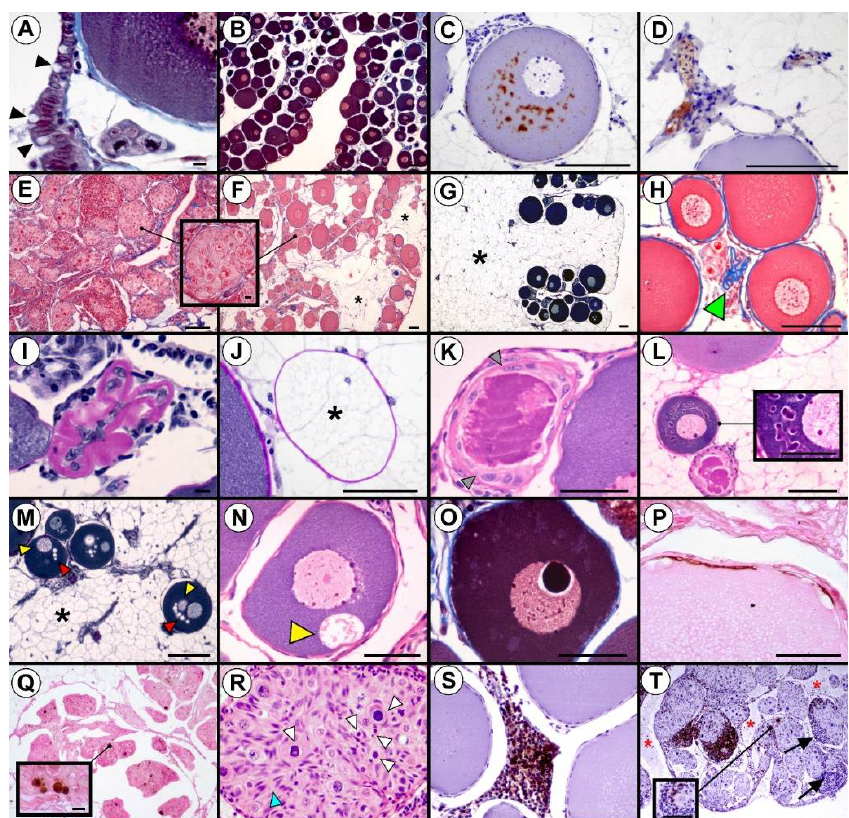
Figure 2. Ovaries of 1600th-day-post-hatching (dph) Russian sturgeon. ( A ) Columnar epithelium in the furrows of the folds. ( B ) Growing ovarian follicles containing perinucleolar oocytes in primary growth stage. ( C ) Deposition of vitellogenin (brown) in ooplasm of small perinucleolar oocyte and ( D ) blood vessel plasma. ( E ) Nests of oogonia and oocytes at the chromatin-nucleolus stage. ( F ) Ovarian nests among sparse ovarian follicles. Magnification between ( E ) and ( F ): Oogonia and oocytes at the chromatin-nucleolus stage inside the ovarian nest. ( G ) White fat tissue in the germinal region of the gonad. ( H ) Final phase of follicular atresia. ( I ) Residual follicular cells and ( J ) adipocytes inside a completely phagocytized follicle. ( K ) Advanced stage of follicular atresia. ( L ) Normal ovarian follicle (at the top), early stage of follicular atresia (in the middle) and advanced stage of follicular atresia (at the bottom). Magnification inside ( L ): Heterogeneous ooplasm of degenerating perinucleolar oocyte. ( M ) Vacuoles and ( N ) autophagosomic bodies within the ooplasm of degenerating perinucleolar oocytes at an early stage of follicular atresia. ( O ) Large vesicles in the nuclei of degenerating perinucleolar oocytes at early stage of follicular atresia. ( P ) Follicular cell apoptosis (brown nuclei). ( Q ) and magnification inside: Apoptosis of oogonia and chromatin-nucleolus oocytes (brown nuclei). ( R ) Nest with multiple atretic oogonia and oocytes at the chromatin-nucleolus stage. ( S ) Small cluster of lymphocytes ( T ) (dark brown) between ovarian follicles. ( T ) and magnification inside: Oogonia and primary chromatin-nucleolus stage oocyte nests infiltrated by T- (dark brown) and B-cells (blue). Indicators: secretory cells resembling goblet cells (black arrowhead), adipocytes (black stars), basement membrane (green arrowhead), hypertrophied follicular cells (grey arrowheads), autophagosomic bodies (yellow arrowheads), vacuoles (red arrowheads), prefollicular cells (blue arrowhead), pyknotic nuclei at di ff erent stages of oogonia / chromatin-nucleolus oocyte atresia (white arrowhead), B lymphocytes (black arrows), and interstitial and superficial fluid containing leukocytes (red stars). Staining: Masson trichrome ( A , B , O ), immunohistochemical (IHC)—anti-vitellogenin antibody ( C , D ), Azan trichrome (( E , F ) and magnification in between, ( H )), PAS with Weigert’s iron hematoxylin ( G , M ), AB / PAS ( I , J ), H-E (( K , L ) and magnification inside, ( N , R )), TUNEL (( P , Q ) and magnification inside), IHC—anti-CD 3 antibody (( S , T ) and magnification inside ( T )). Scale bars : ( A ), magnification between ( F ) and ( E , I , M ) and magnification inside ( Q ) = 10 µ m; ( B – H , L , Q – T ) = 100 µ m; ( J , K , N – P ) and magnification inside ( L , T ) = 50 µ